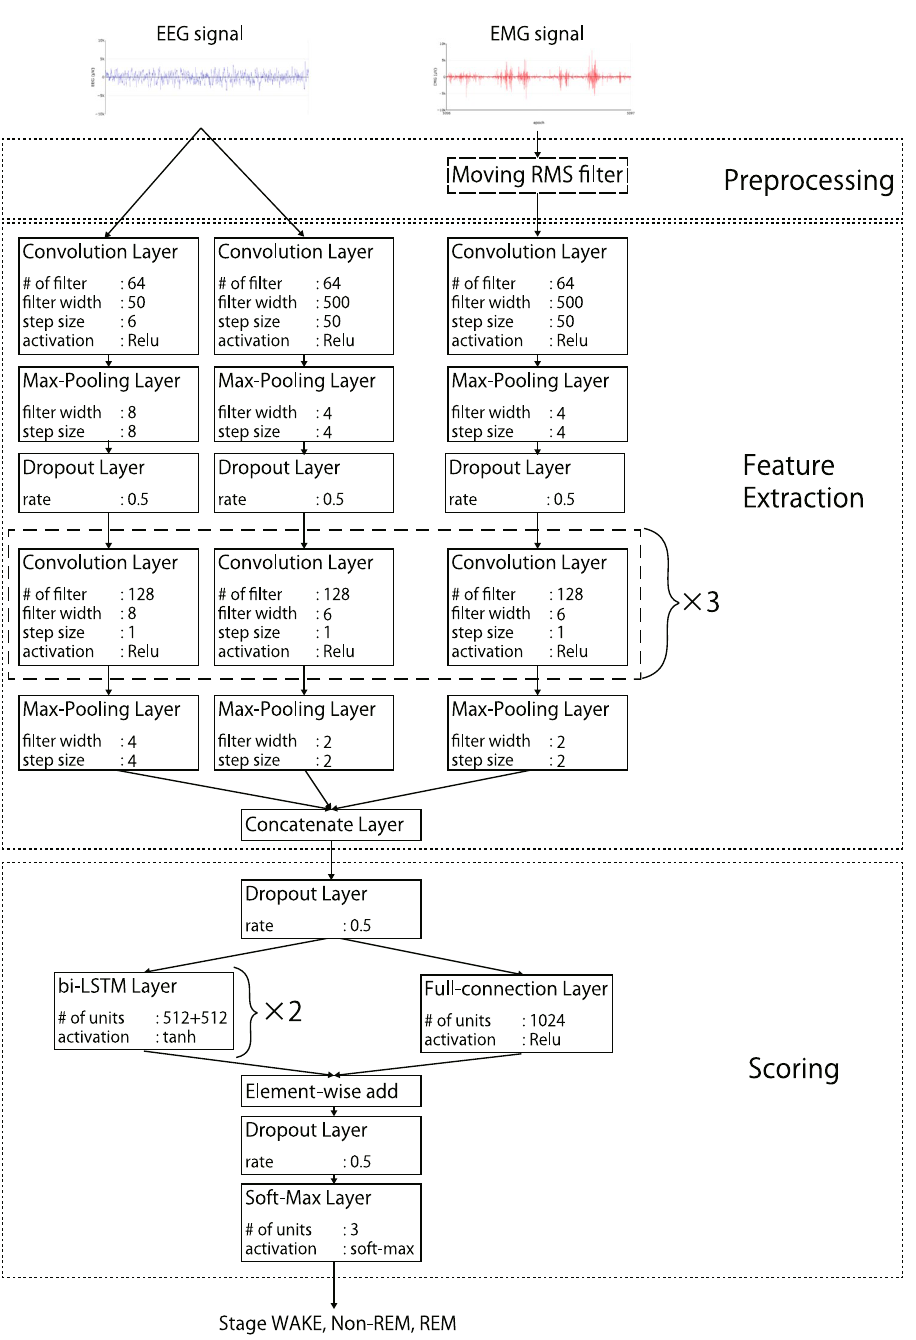
Figure 2. Structure of MC-SleepNet. MC-SleepNet uses eight types of layers: convolution, max-pooling, dropout, concatenate, element-wise add, bi-LSTM, full-connection, and softmax layers. The parameters of each layer are illustrated in the